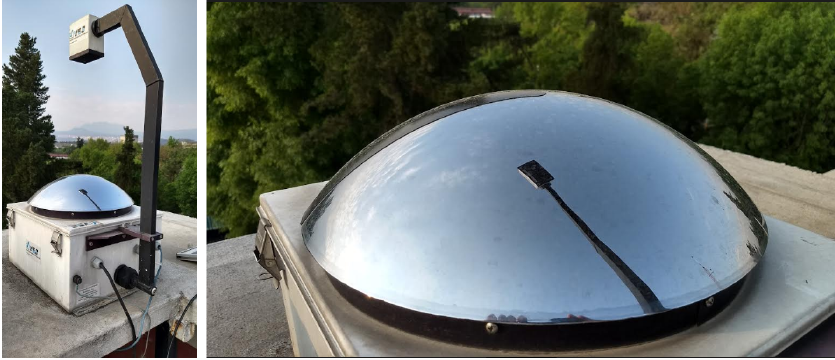
Figure 1. Sky Camera—TSI 880